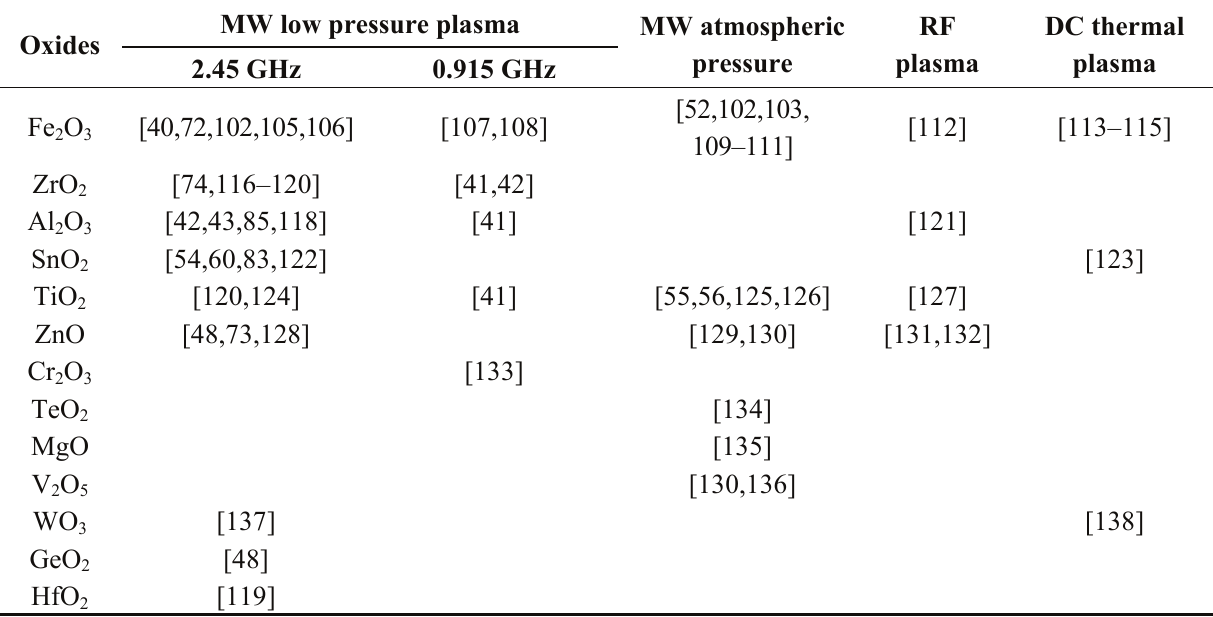
Table 2. Overview on published papers related to the subject of oxide nanoparticles, synthesized in microwave